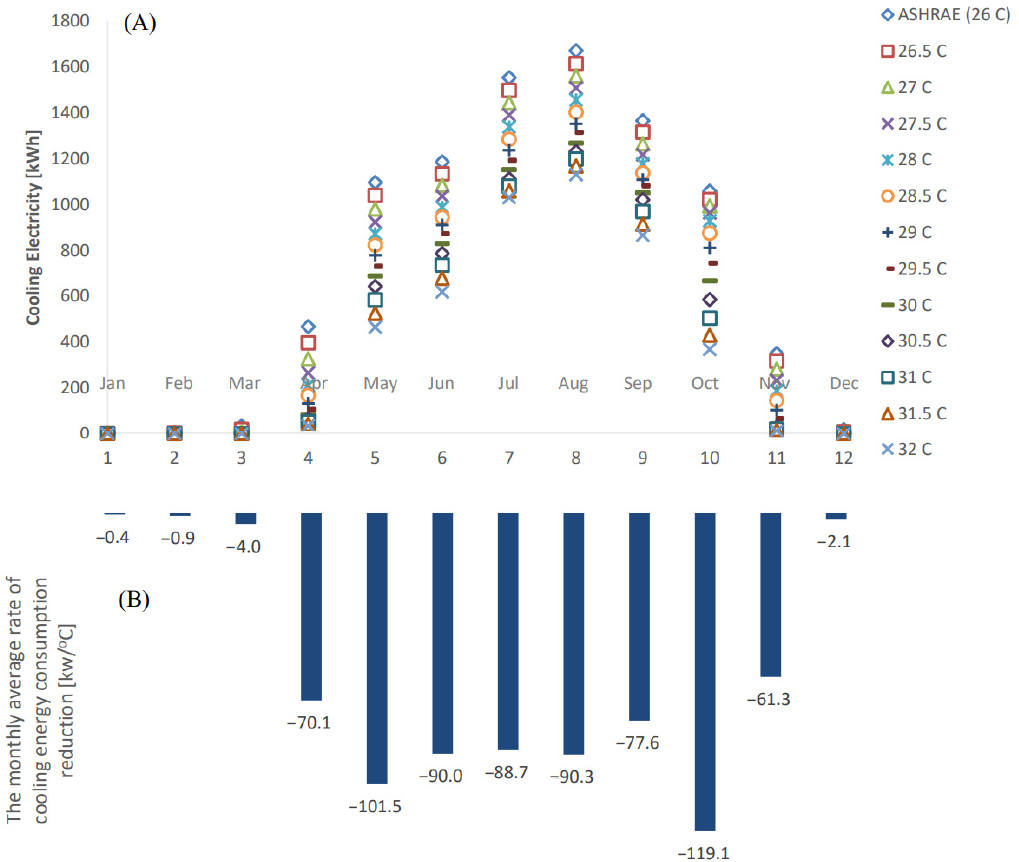
Figure 8. ( A ) The monthly cooling energy consumption with respect to the cooling setpoint; ( B ) The monthly average rate of cooling energy consumption reduction with respect to the cooling setpoint temperature increase ( dE c / dt s ).